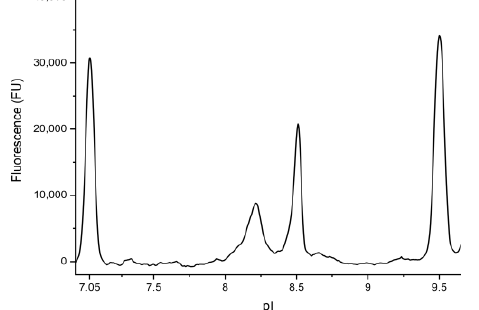
Figure 2. Representative electropherogram of BMP-2 (two peaks at 8.2 and 8.5) and adjacent isoelectric point (pI) markers (7.05 and 9.5).